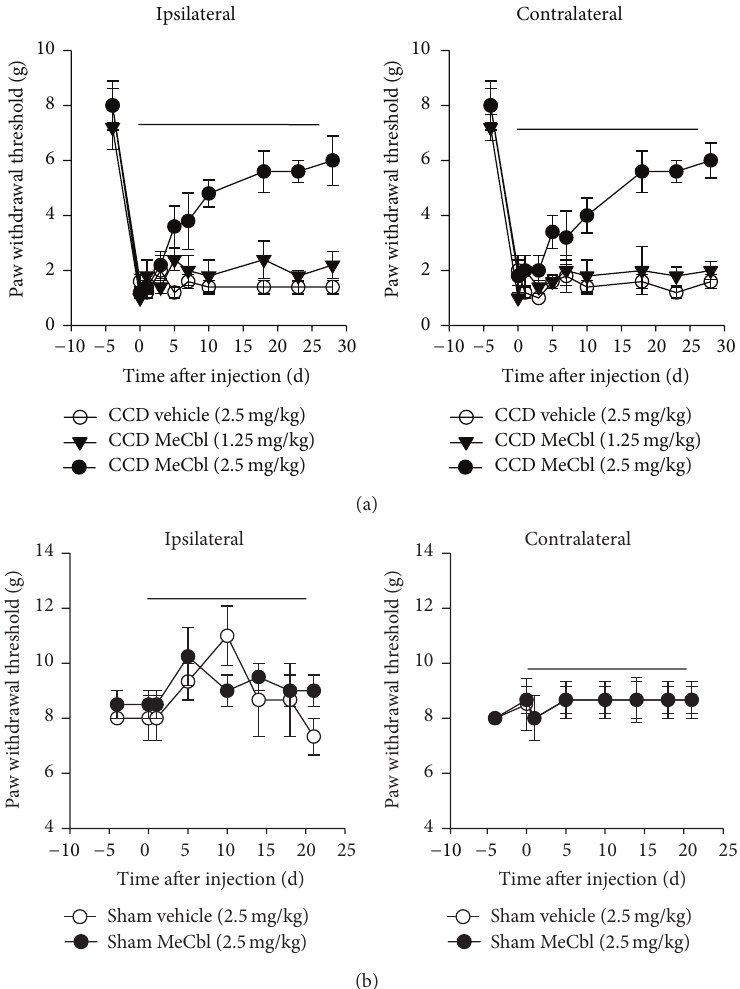
Figure 2: Continuous treatment of MeCbl inhibited bilateral mechanical allodynia of CCD rats. Continuous treatment of MeCbl (1.25 mg/kg and 2.5 mg/kg) or Mannitol (2.5 mg/kg) was injected intraperitoneally from the 3rd postoperative day (black line segment). (a) Effects of MeCbl on bilateral mechanical paw withdrawal thresholds of CCD rats. (b) Effects of MeCbl on mechanical paw withdrawal thresholds of sham rats.